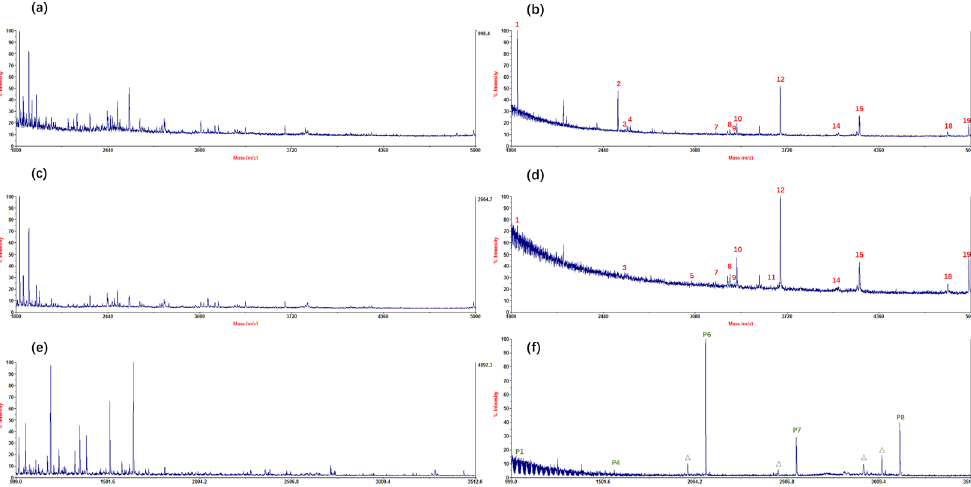
Figure 4. MALDI-TOF mass spectra for the glycopeptide enrichment from a mixture of HRP and BSA at a mass ratio of 1:50: ( a ) before enrichment, and ( b ) after enrichment; 1:100: ( c ) before enrichment, and ( d ) after enrichment; for the phosphopeptide enrichment from a mixture of β -Casein and BSA at a mass ratio of 1:500: ( e ) before enrichment, and ( f ) after enrichment, where glycopeptides were marked with Arabic Numerals in red, phosphopeptides were marked with Arabic Numerals in green, and Δ indicates the losses of phosphoric acid.